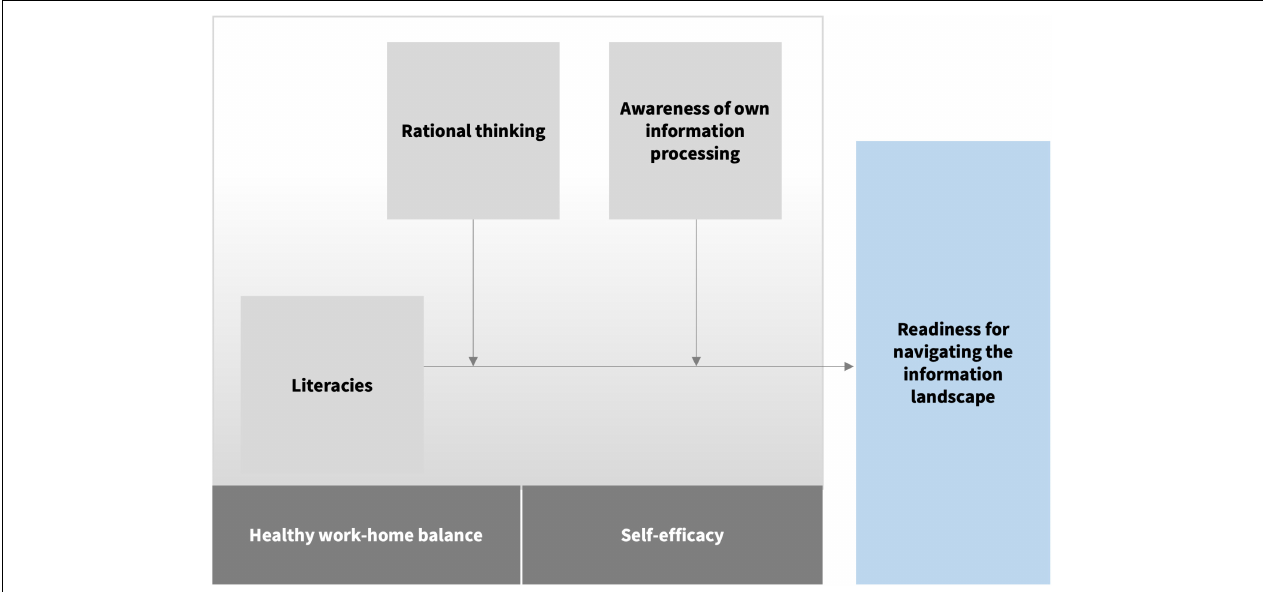
FIGURE 1 | The proposed model of the relationship between literacies and readiness for navigating the information landscape, moderated by rational thinking and awareness of own information processing. Here, literacies are defined as “competencies and dispositions that support individual comprehension and use of information in daily activities”; rational thinking as “reflective, effortful processing of information”; and awareness of own information processing as “using psychological knowledge to take stock of own mental operations”. Healthy work-home balance and self-efficacy are also components of the educational sphere that may contribute to readiness for navigating the information